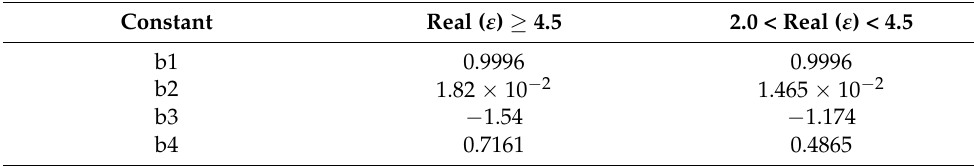
Table 2. Asymmetry factor constant K coefficients.